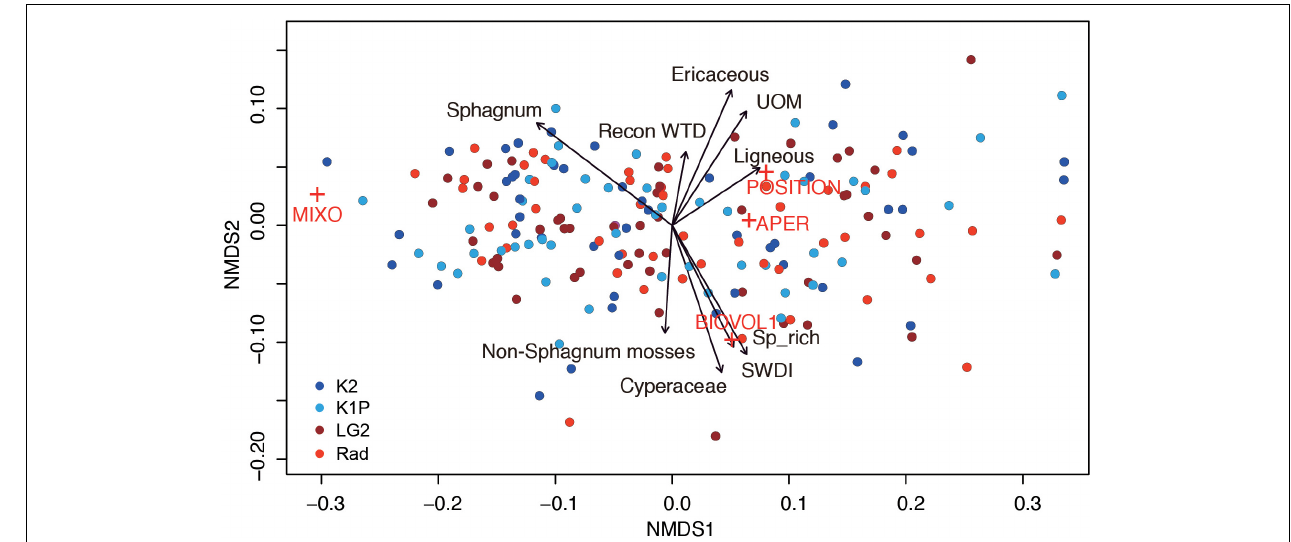
FIGURE 7 | Non-metric multidimensional scaling of testate amoeba functional traits (stress: 0.04; MIXO: mixotrophy; BIOVOL: biovolume; APER: aperture size; POSITION: aperture position) with reconstructed water-table depth (WTD), testate amoeba richness (Sp_rich), diversity (SWDI), and vegetation types as environmental factors (all factors are significant with p < 0.01). UOM: Unidentifiable organic matter. Red crosses indicate testate amoeba functional traits and circles with the same color indicate samples from the same